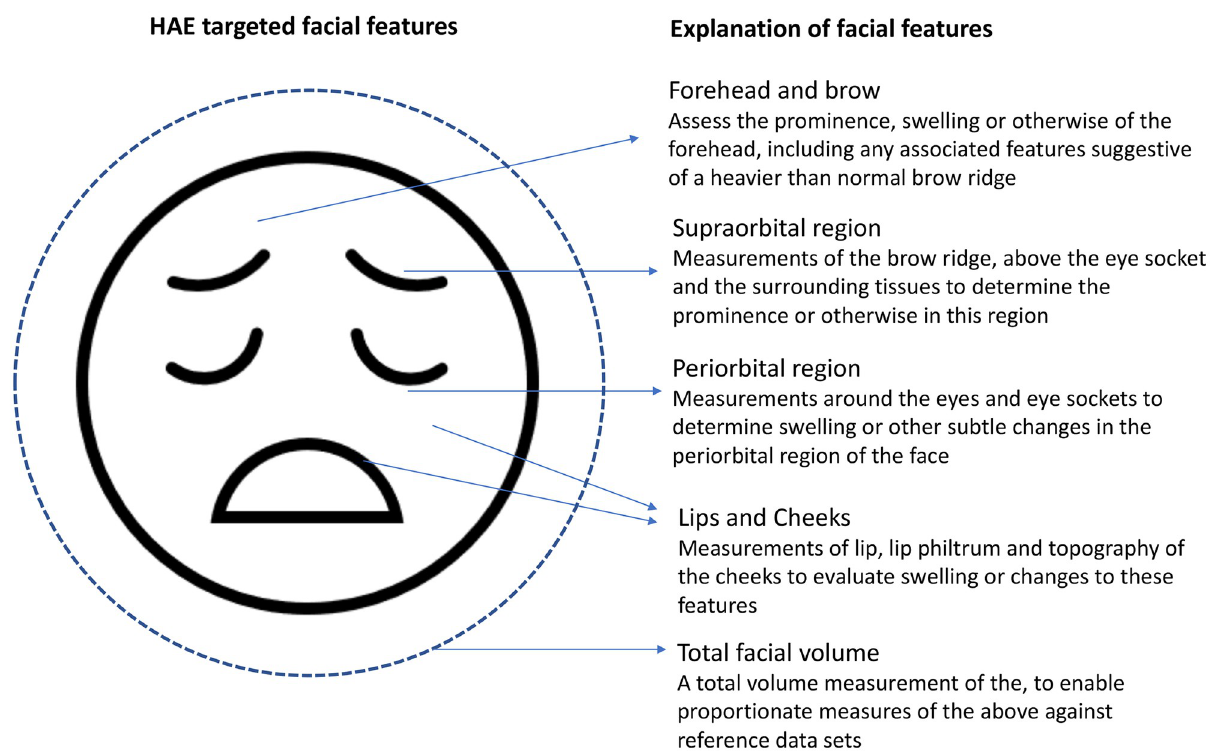
Fig 2. Features and importance of various facial elements and their resultant impact from people living with HAE amenable to Cliniface 3D photogrammetric analysis. Subtle or drastic changes owing to